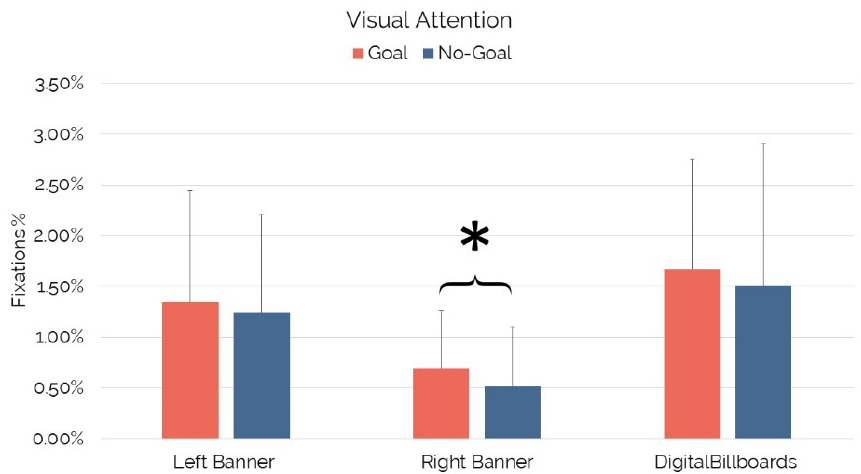
Figure 3. Visual attention for IGAs in “Goal” and “No-Goal” scenes. Error bars represent standard deviation. Asterisks indicate statistically significant differences.